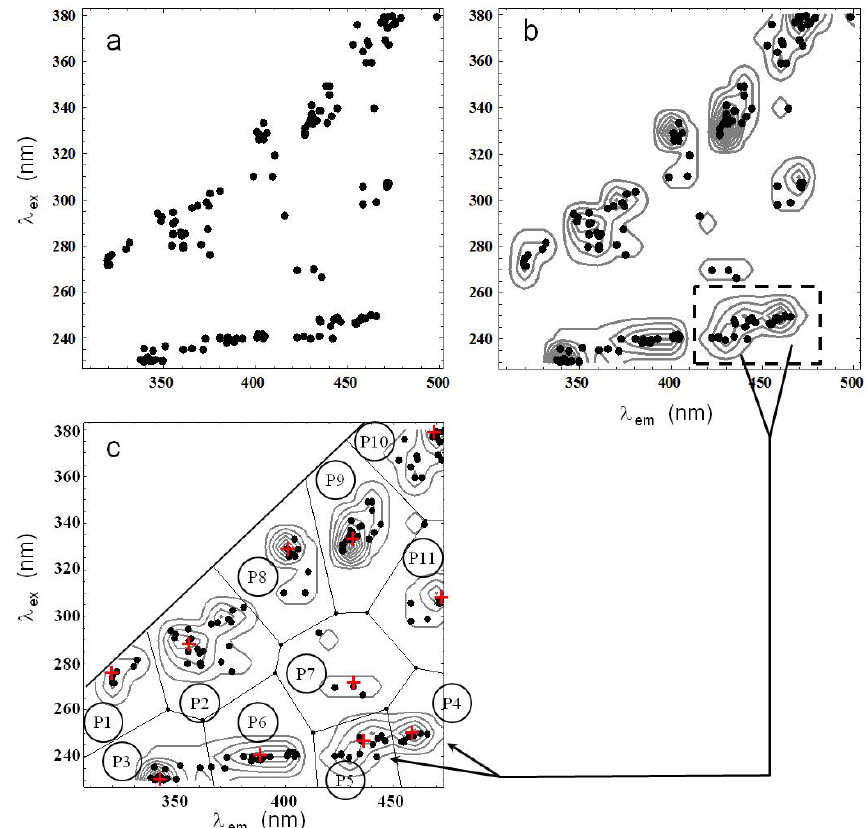
Fig. 7. (a) Scatter plot showing the position of all the peaks identified in all samples after the deconvolution (black dots) within the exci- tation vs. emission plane; (b) Contour plot of the scatter plot generated by converting the two-dimensional data into an array of counts of width of 10. This data representation allows to discern visually ten groups. Dashed rectangle highlights points located at λ ex < 250nm and 420 <λ em < 500nm. These points are further split into two clusters to obtain a total number of eleven clusters; (c) Voronoi diagram of the eleven peaks showing the limits of each cluster. Red “ + ” symbols show the centre of each cluster. Numbers into white circles label the eleven peaks in the